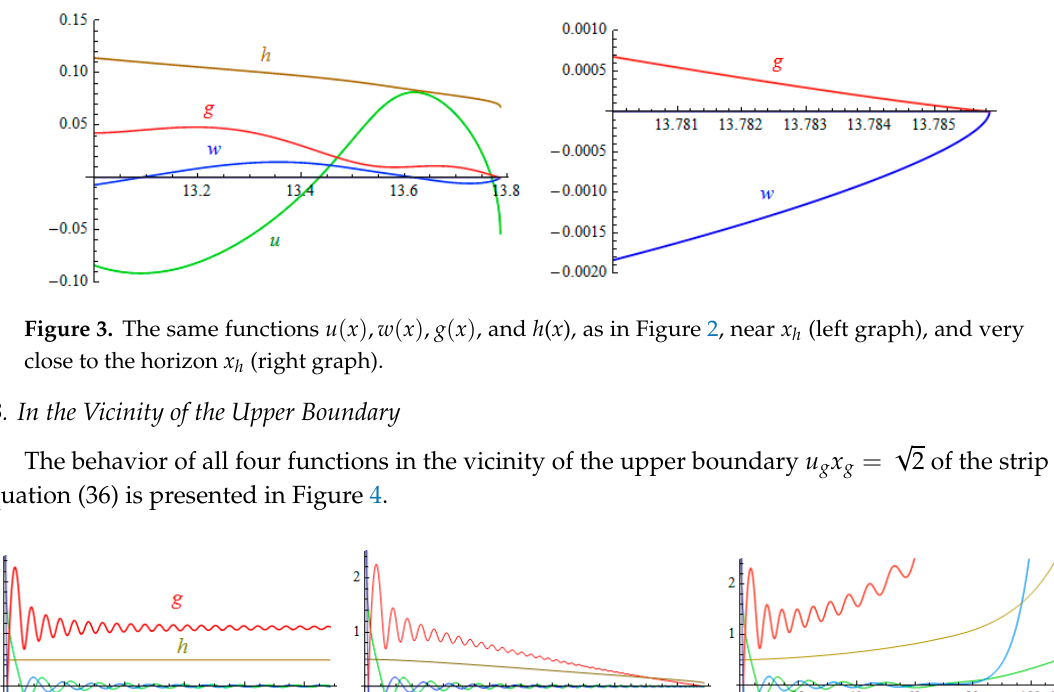
Figure 3. The same functions ),(),(),( xgxwxu and h ( x ), as in Figure 2, near h x (left graph), and very close to the horizon h x (right graph).